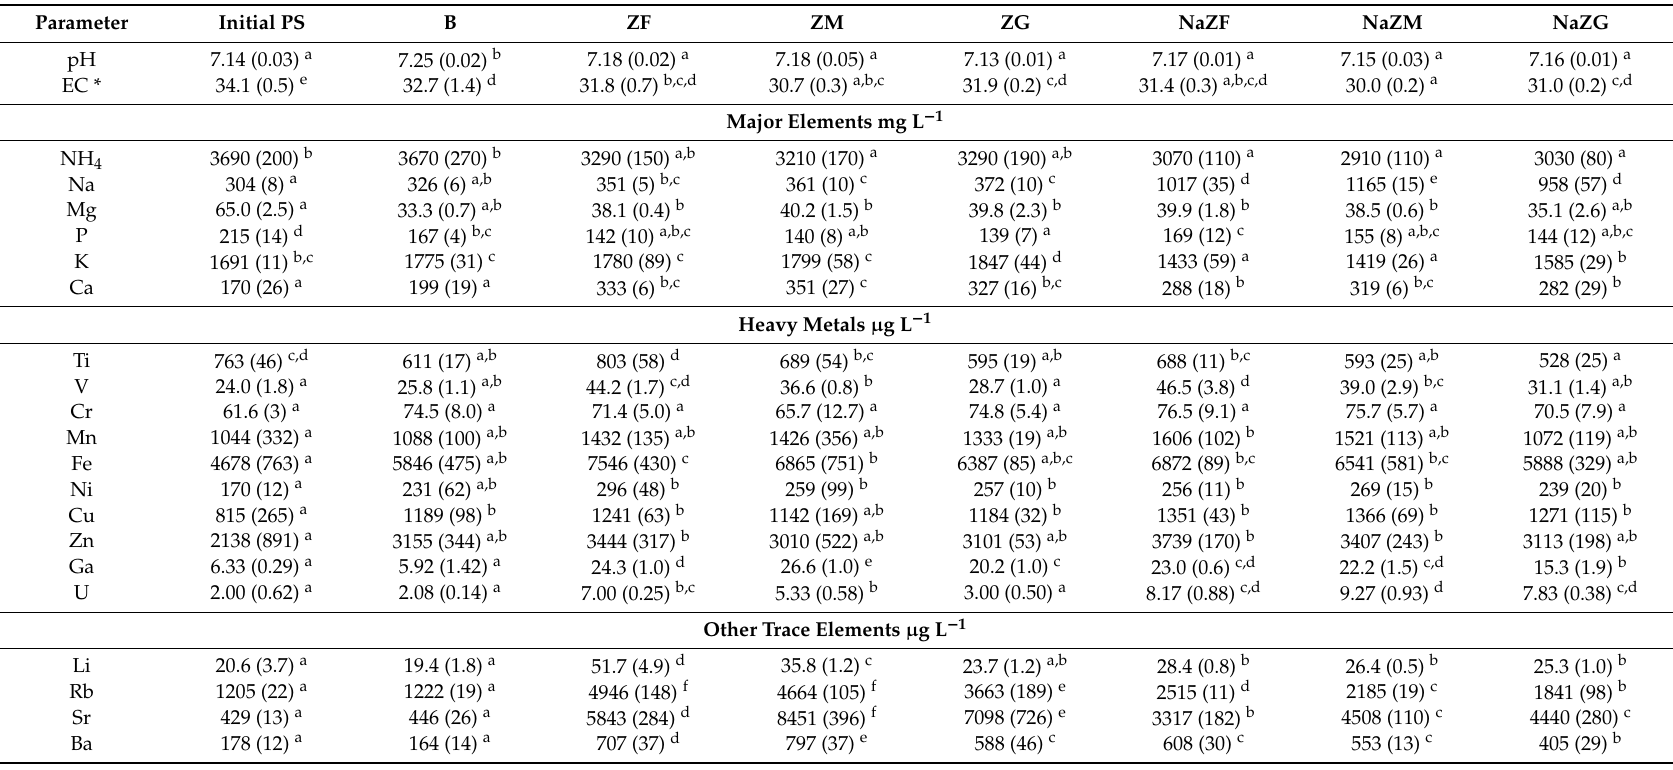
Table A1. Chemical composition of the studied pig-slurry (PS) before and after the first treatment cycle with natural ZTs (ZF, ZM, and ZG) and Na-exchanged ZTs (NaZF, NaZM, and NaZG) and in blank samples (without ZTs, B). Standard deviation within brackets (three replicates). Di ff erent letters (a,b,c,d,e) indicate significant di ff erences obtained from ANOVA and Tukey HSD tests. * Electrical conductivity is reported in mS cm − 1